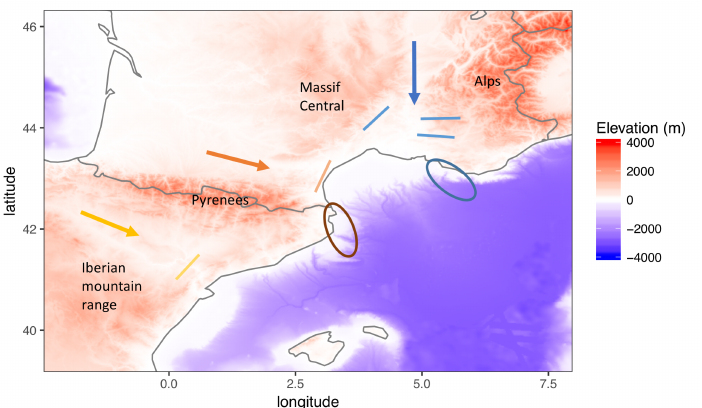
Figure 2. Orography and bathymetry [11] of Mistral, Tramontane, and Cierzo area (m). The arrows indicate Mistral (blue), Tramontane (orange), and Cierzo (yellow). The oval shape marks the area of highest wind speed underestimation in simulations [13]. The light lines show areas of hydraulic jumps observed by